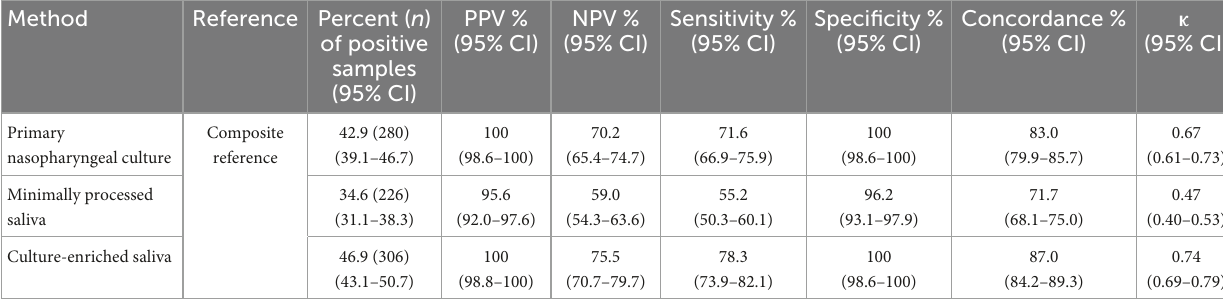
TABLE 2 The accuracy of Streptococcus pneumoniae detection in paired nasopharyngeal and saliva samples from n = 653 children in the Netherlands tested using molecular methods applied to DNA extracted from minimally processed and culture-enriched samples and applying ROCd C q thresholds for sample positivity in